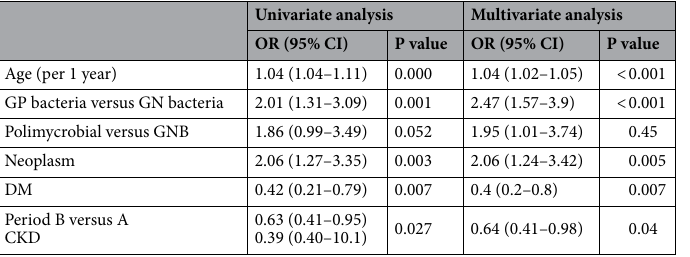
Table 3. Factors associated with the risk of death in univariate and multivariate analysis. DM diabetes, GP Gram positive, GN Gram negative, CKD chronic kidney disease, DM diabetes mellitus, CKD chronic kidney disease.